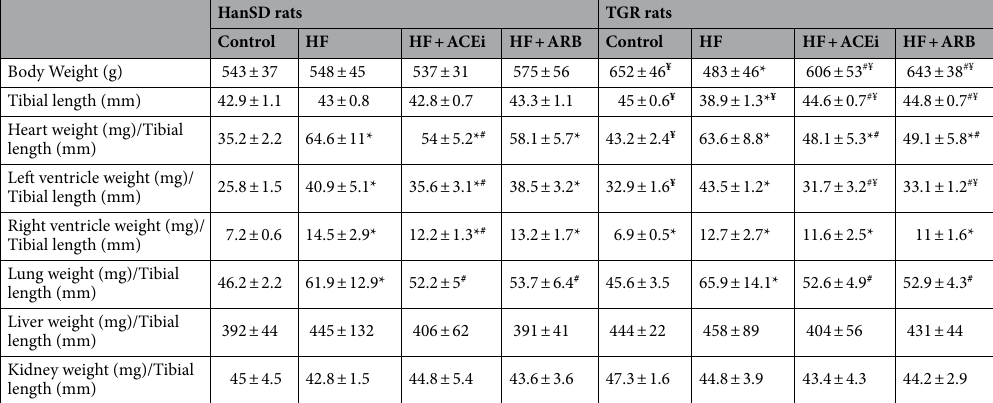
Table 1 summarizes body weights and ratios of organ weights to tibial lengths in control rats, untreated HF rats, and rats treated with either ACE inhibitor or AT 1 blocker. Raw organ weights are also shown in Supplementary Table 1. Untreated Hannover Sprague–Dawley (HanSD) and TGR rats with induced heart failure displayed marked cardiac hypertrophy as is apparent from a significant increase in heart weight/tibial length ratios. ACE inhibitor significantly attenuated the hypertrophic response in both strains of rats. However, AT 1 blocker sig- nificantly reduced heart weights only in TGR rats with ACF. Both right and left ventricle contributed to the observed heart weight increase in ACF rats. Lung weight/tibial length ratios were significantly increased in untreated HanSD and TGR rats with ACF when compared to sham-operated rats, indicating HF-induced lung congestion. Treatment with ACE inhibitor and AT 1 blocker significantly reduced lung congestion in both strains of rats. At 20 weeks after ACF induction, 12 out of 16 untreated (75%) HanSD rats were alive, while there were 11 out of 13 (85 percent) surviving among ACE inhibitor-treated as well as AT 1 blocker-treated HanSD rats. The